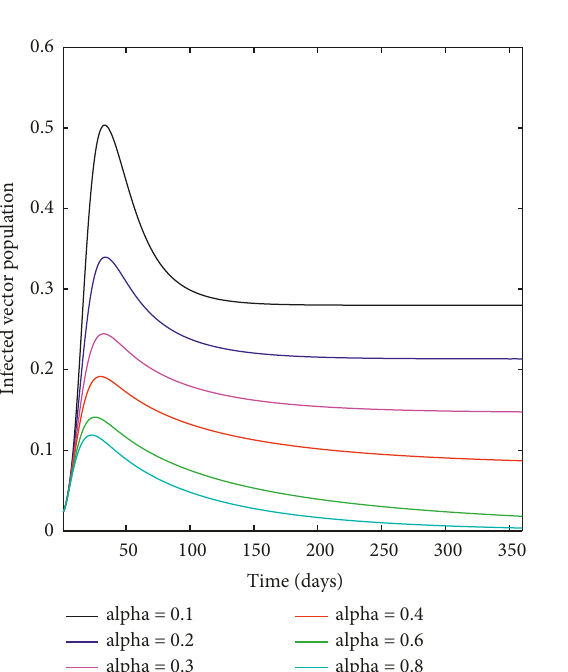
Figure 5: c � 0 for the infected humans.